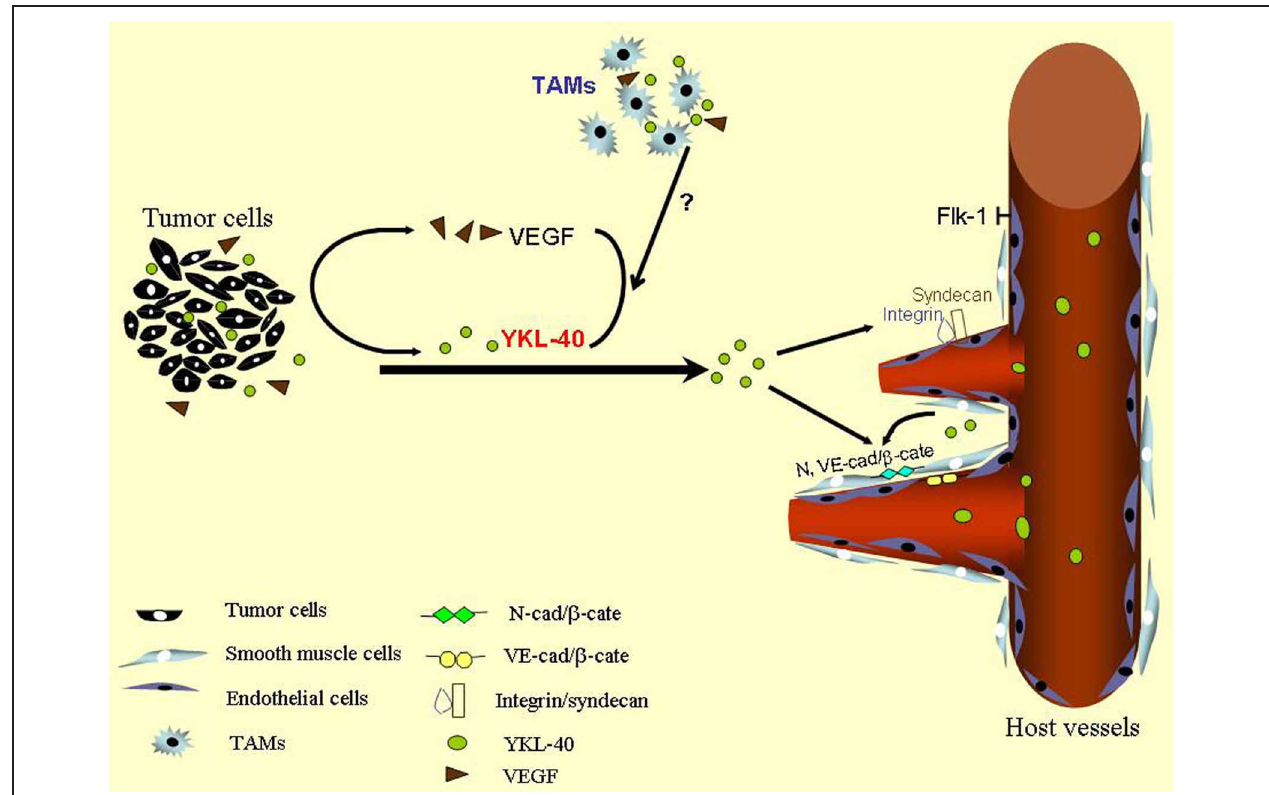
FIGURE 1 | A scheme forYKL-40-induced tumorangiogenesis. YKL-40 secreted from tumor cells stimulates vascular endothelial cell activation to induce tumor angiogenesis through membrane receptor coupling of syndecan-1 with integrin. YKL-40 regulates VEGF in tumor cells and both may synergistically promote endothelial cell angiogenesis. YKL-40 derived from